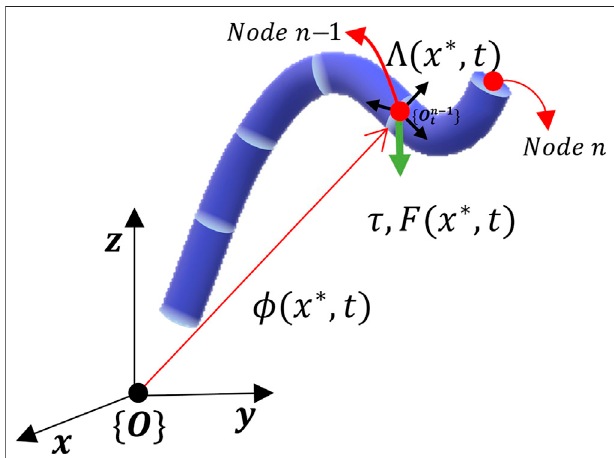
FIGURE 1 | A soft manipulator at time t with discretization nodes n and n − 1areshown. ϕ ( x * , t ) and Λ ( x p , t ) denotethepositionandtheorientationof cross-sectionofNode n − 1,respectively.Inaddition,theforce F ( x * , t ) ,torque τ ( x * , t ) , and the conservative force f c (e.g., gravity) are applied to Node n − 1 at the position ϕ ( x * , t )